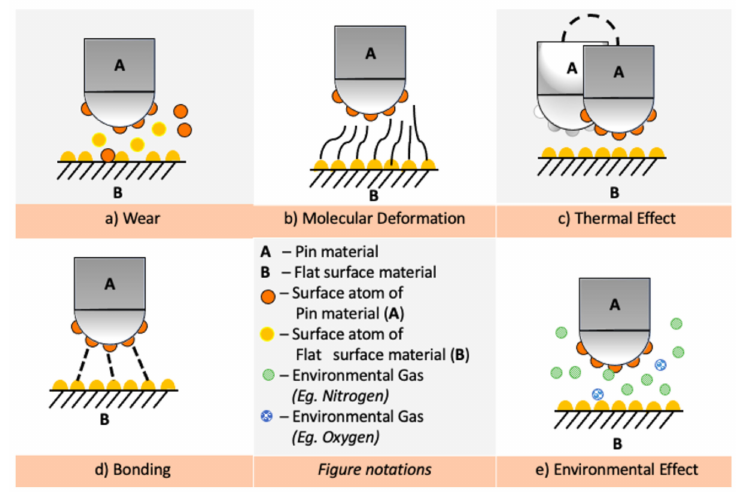
Figure 3. Different microscale mechanisms of frictional energy dissipation: ( a ) Wear mechanism; ( b ) Molecular deformation; ( c ) Thermal Effect; ( d ) Bonding; and ( e ) Environmental effect [28]. (a) Wear